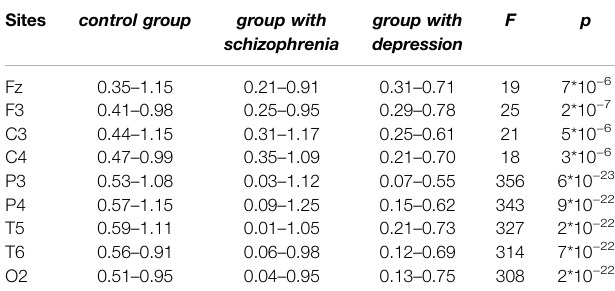
TABLE 2 | Comparison of the averaged (over subjects) maximal and minimal values of the Holder exponent ( h min and h max ) in various sites for different groups. The values of the Fisher test ( F ) and the signi fi cance level of the test ( p ), calculated on the basis of one-way analysis of variance are given for the multiple comparison for the width of the singularity